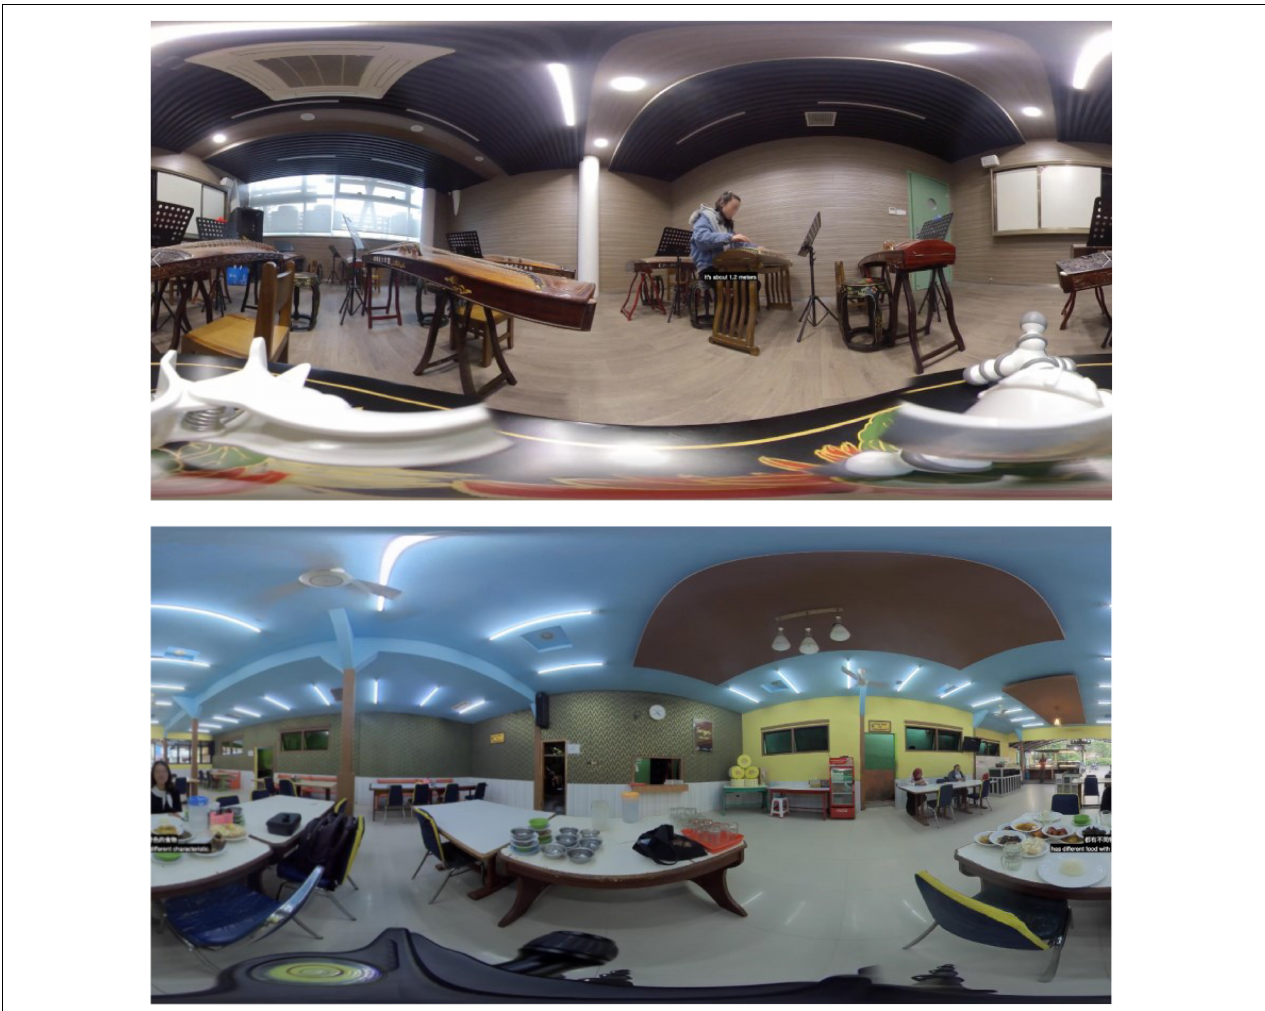
FIGURE 2 | Screenshots of 360-degree